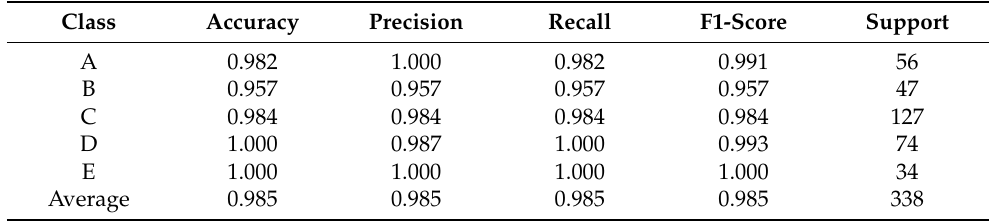
Table 6. The results of each class on Dataset A.